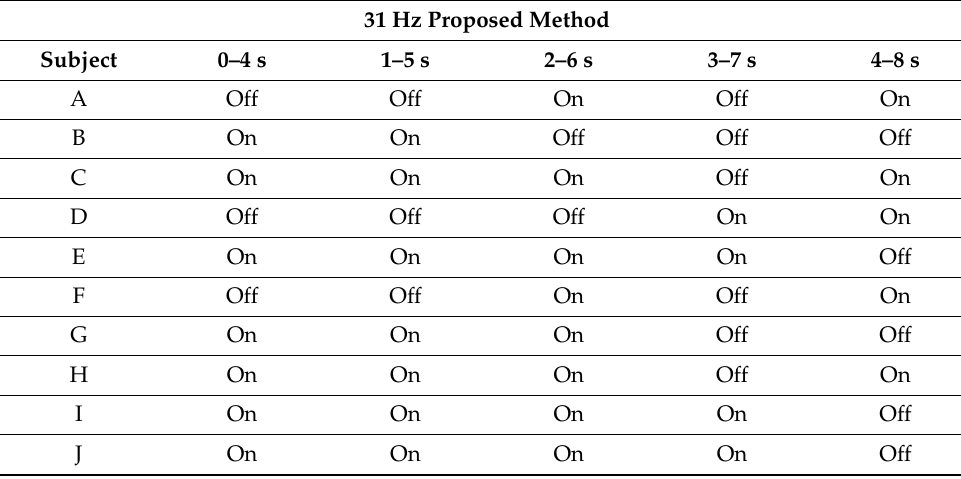
Table 5. The proposed method has five signals in the 31 Hz brainwave